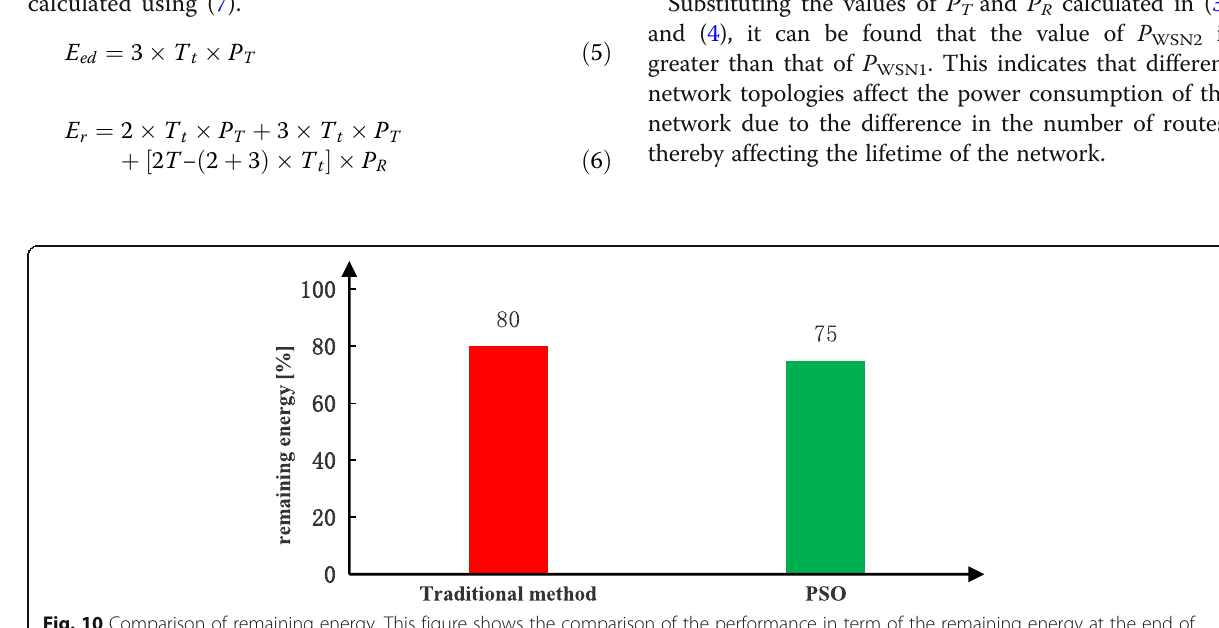
Fig. 3a, the total energy consumption of end-devices can be calculated as shown in (5). The second and third node acts as routers to transmit information and also receives information, that is combining the data it owns with the data received from them child nodes and sends it to the coordinator. From Fig. 3b, the amount of energy consumption of routers can be calculated based on (6) in a similar way. Therefore, the power consumption of a network round is the sum of the power consumption of each node, and is calculated using (7).